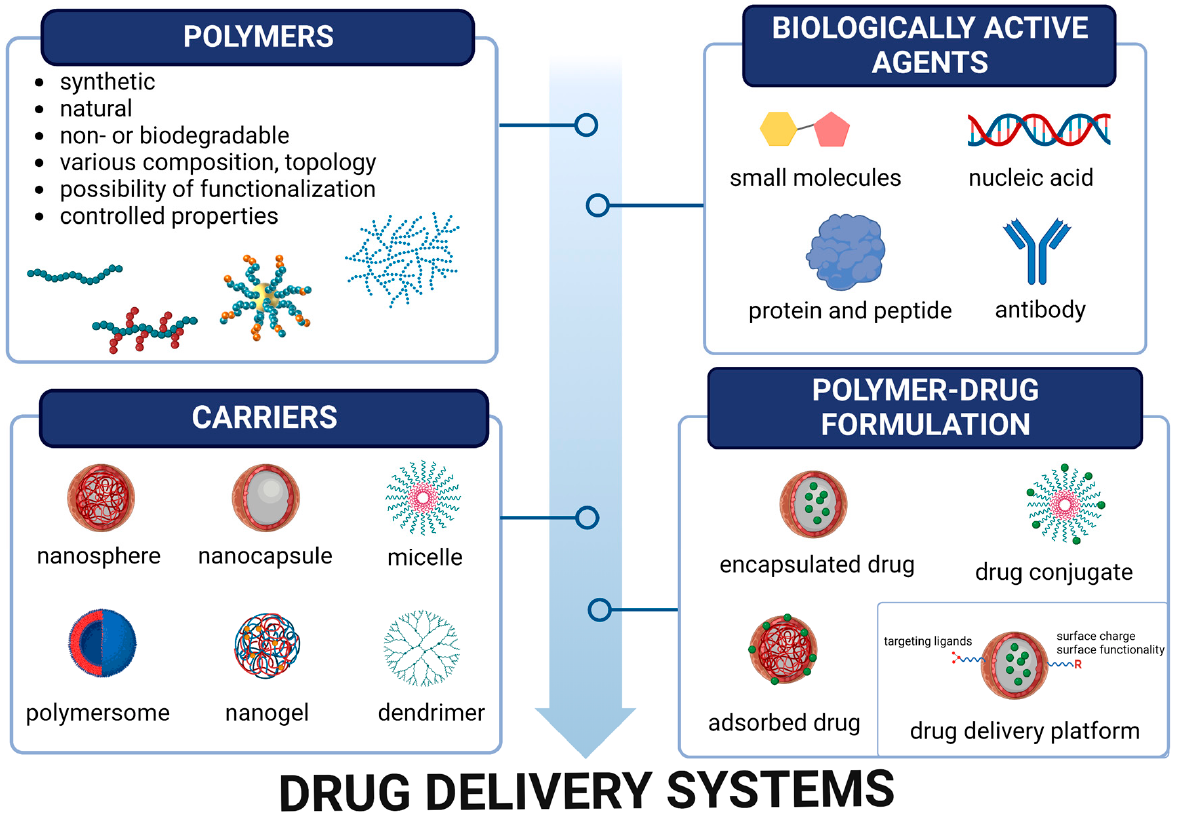
Figure 1. Schematic representation of the formulation of polymeric carriers for delivery systems in biomedical applications.